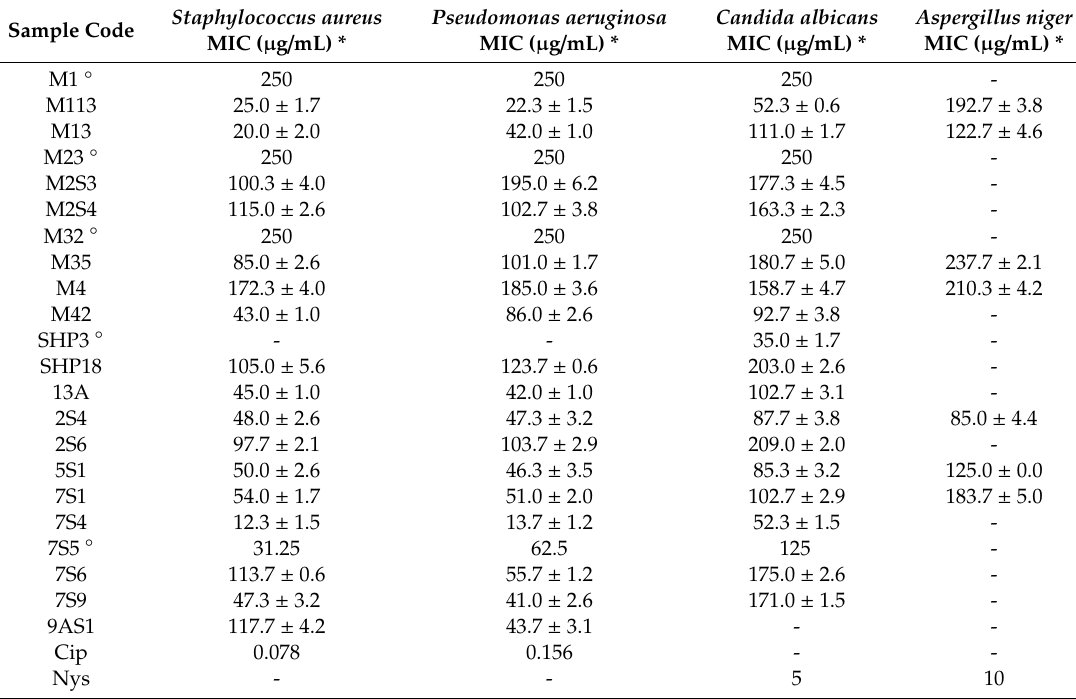
Table 2. Antimicrobial activity of the fungal